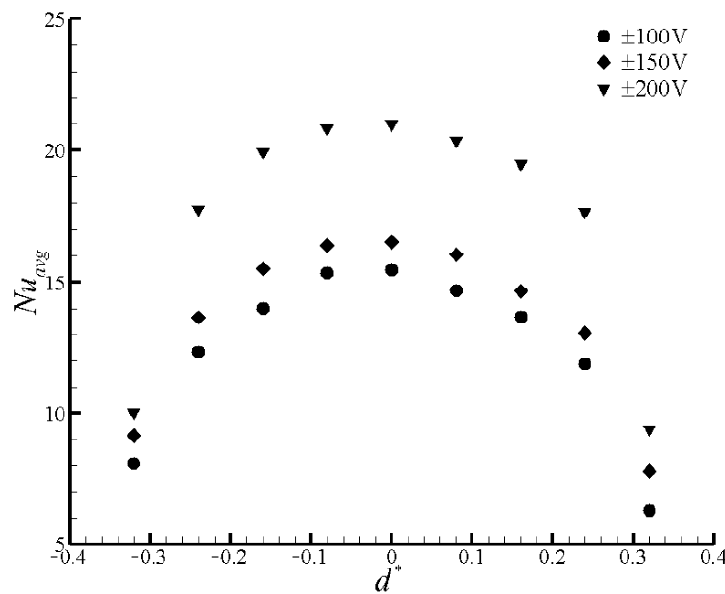
Figure 10. Nu avg variations with driving voltage and slider location.